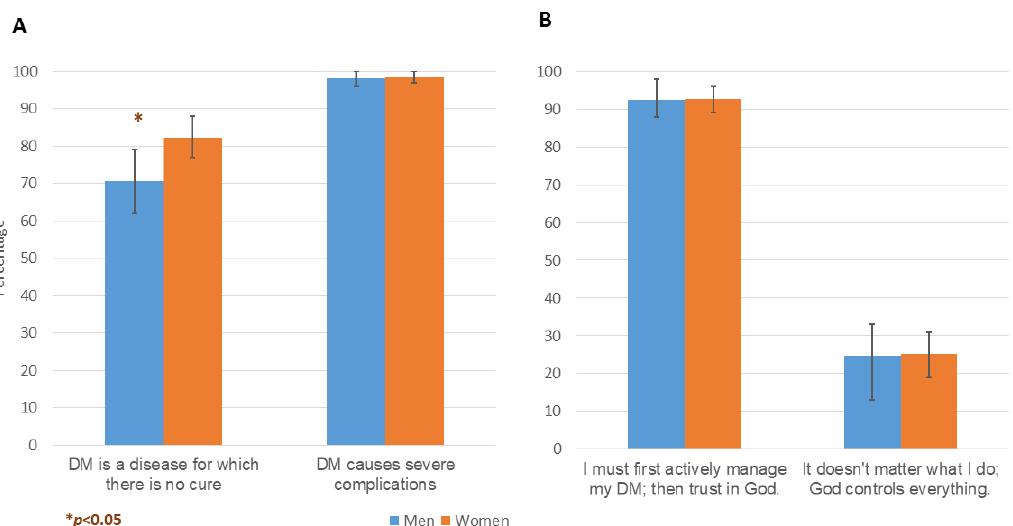
Figure 1. DAPI participant understanding of diabetes (Panel ( A )) and attitudes toward its manage- ment (Panel ( B )). The error bars represent 95% confidence intervals.